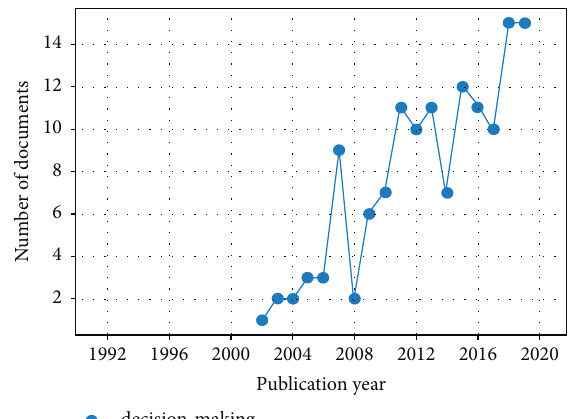
Figure 5: Integrated timeline graph for publications with opti- mization or optimisation as keywords during the period 1991–2020.